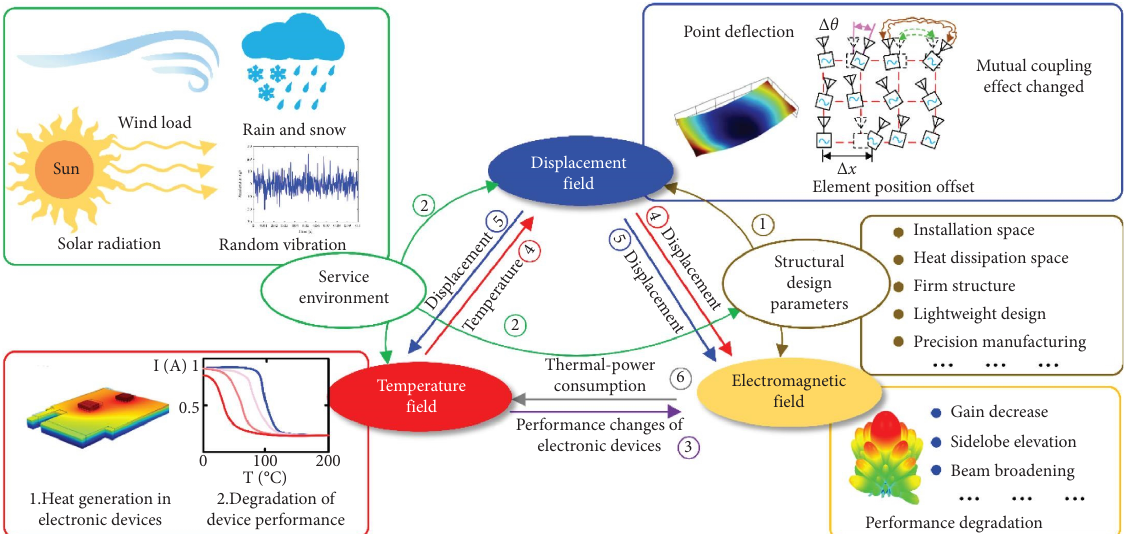
Figure 1: Structural-electromagnetic-thermal coupling relationship of